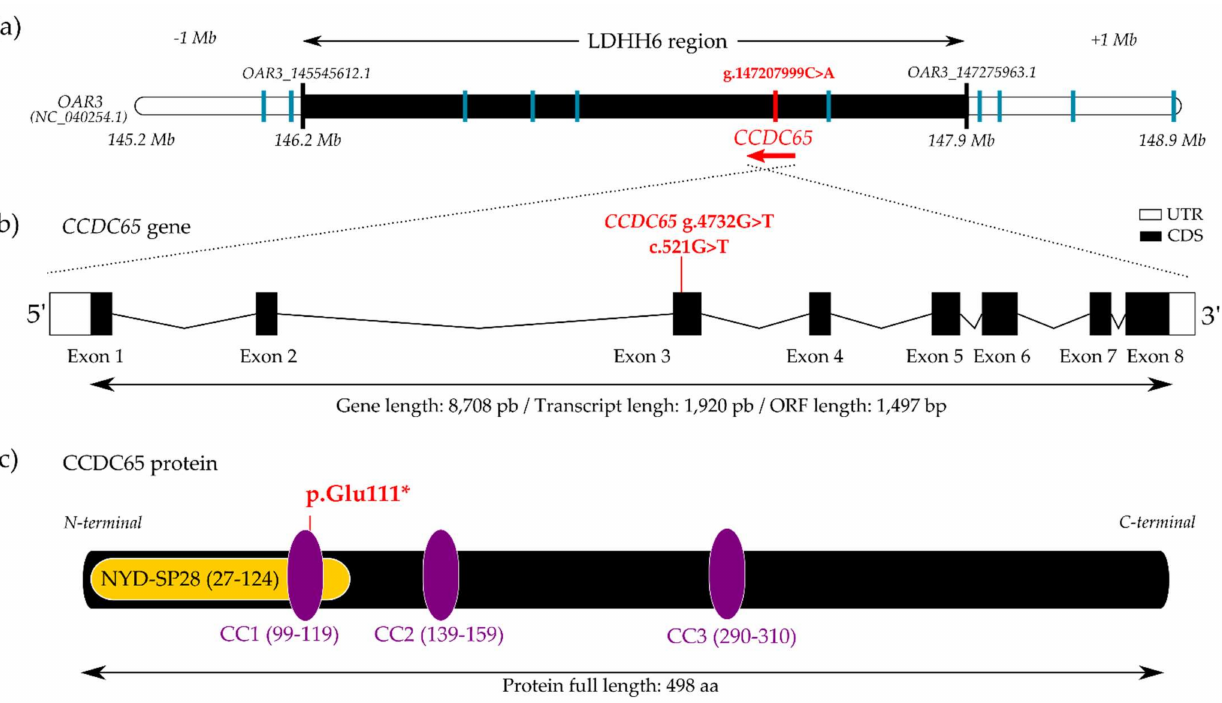
Figure 1. Nonsense variant in CCDC65 gene associated with the LDHH6 lethal haplotype. ( a ) LDHH6 haplotype (NC_040254.1:OAR3:146,243,481pb-147,946,399pb) extended by 1 Mb from each side. The black bar indicates the limits of LDHH6 haplotype with the first and last markers (Illumina OvineSNP50 OAR3_145545612.1 and OAR3_147275963.1). Vertical lines indicate the positions of the candidate causal SNV in CCDC65 (red) and 10 other SNVs fully associated with LDHH6